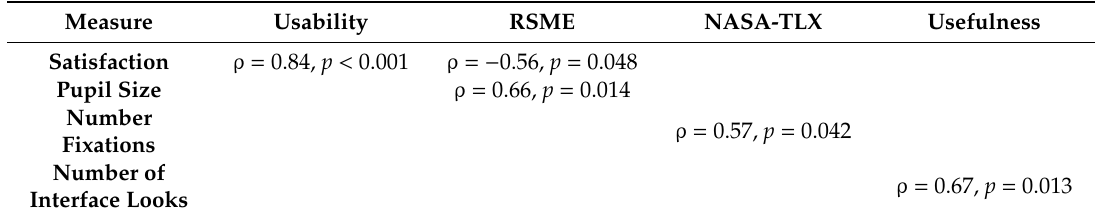
Table 7. Correlations between